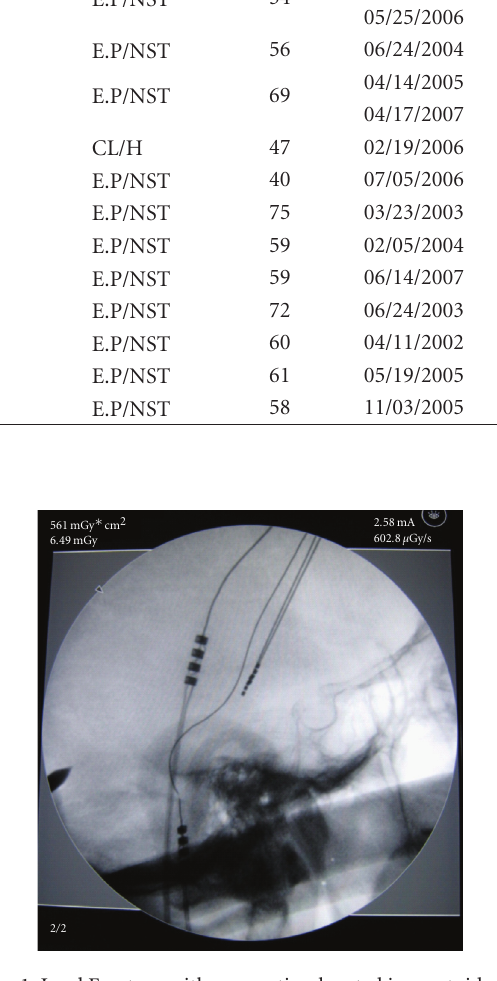
Figure 1: Lead Fracture with connection located in mastoid